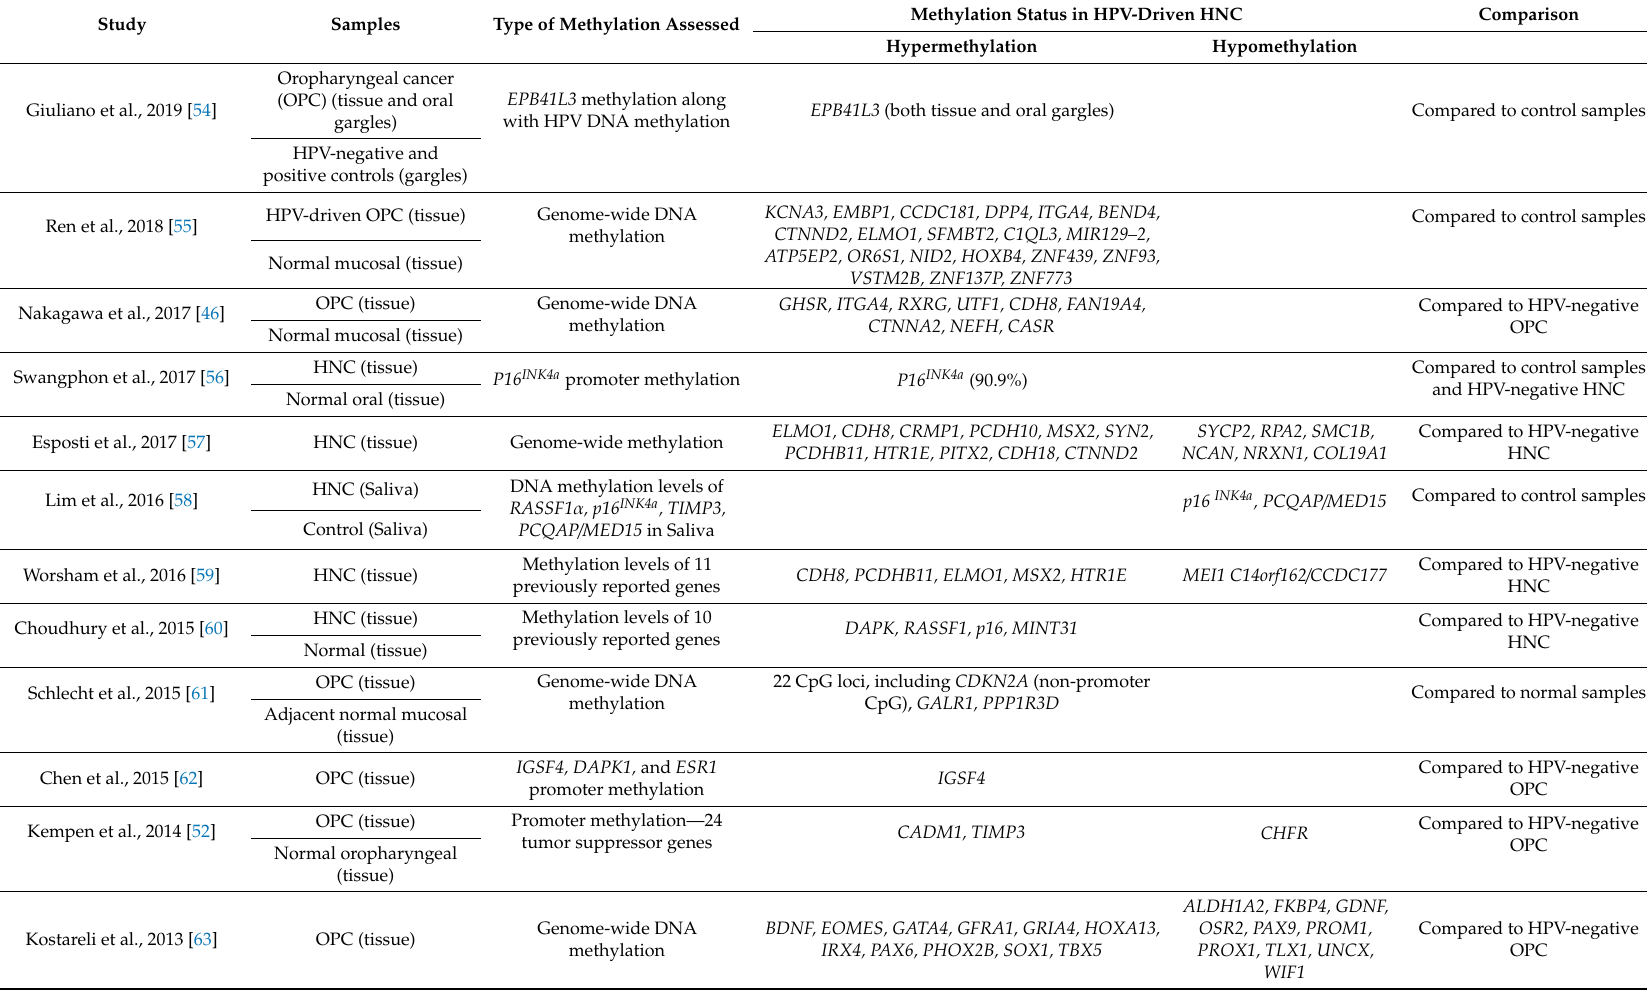
Table 1. Di ff erentially methylated genes and loci in HPV-driven head and neck cancer (HNC)